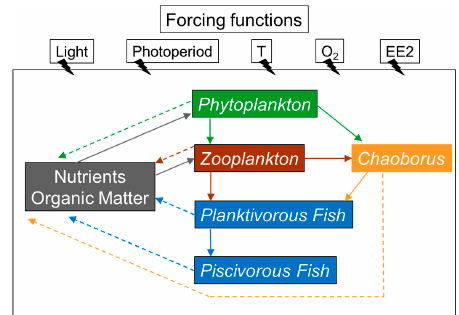
Figure 3. Simplified framework of the ecosystem model built in WEST with AQUATOX equations (full arrow: consumption terms; dashed arrow: loss terms). Extension of Figure 2 in Clouzot and Vanrolleghem [12].